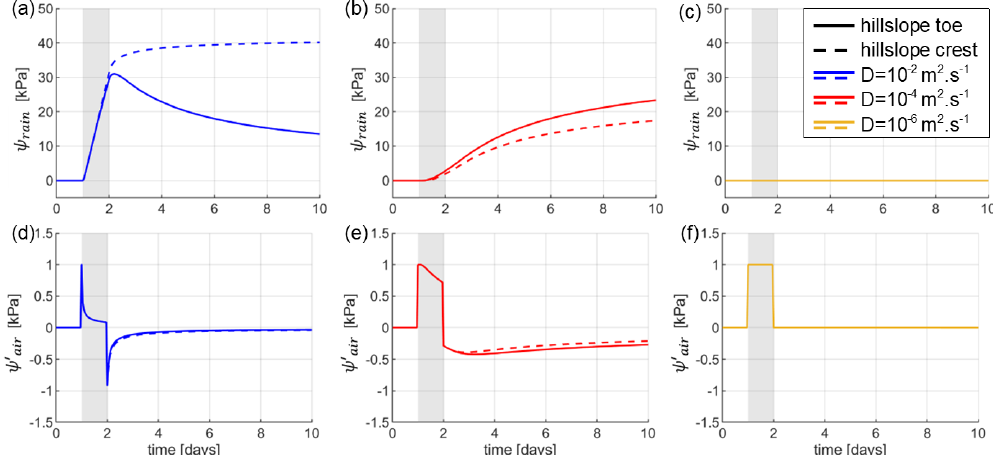
Figure 3. Temporal evolution of ψ rain (a–c) and ψ (cid:48) (d–f) in response to the synthetic forcing (Fig. 2), at several diffusivities. Solid lines air represent atmospheric and rainfall effects at the toe of the hillslope at x = 50m, and dashed lines the effect at the crest of the hillslope at x = 500m. Note the difference of scale on the y axis for (a) – (c) compared to (d) – (f) .